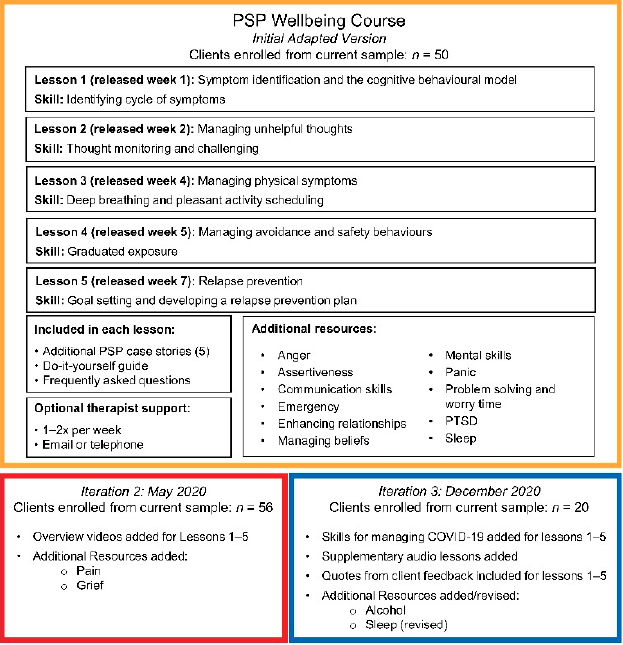
Figure 2. Description of the PSP Wellbeing Course.